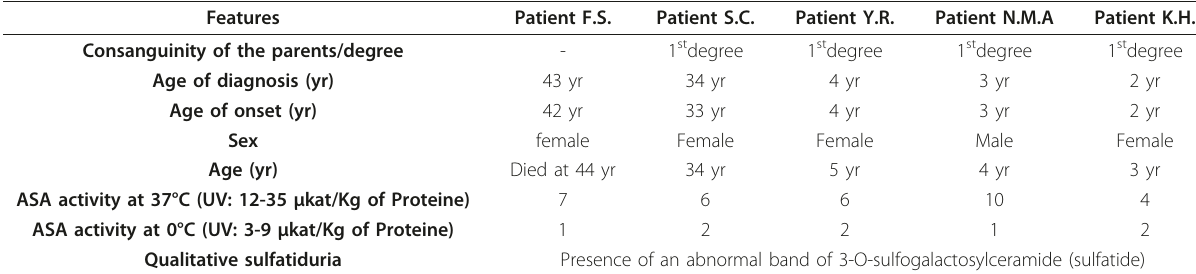
Table 1 Description of the 5 MLD patients.